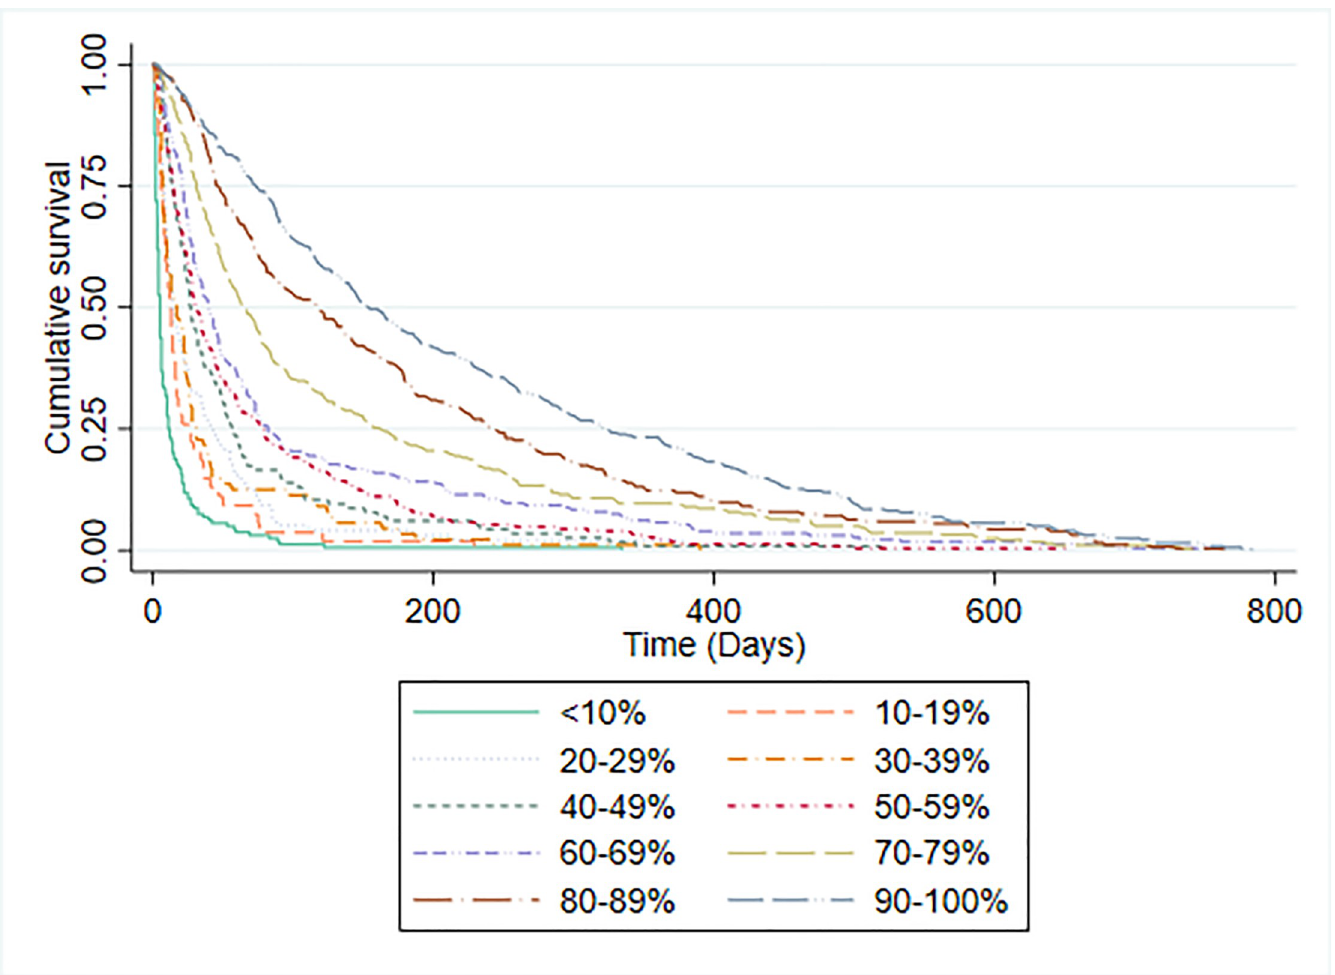
Fig 4. Kaplan-Meier survival curves by 30-day